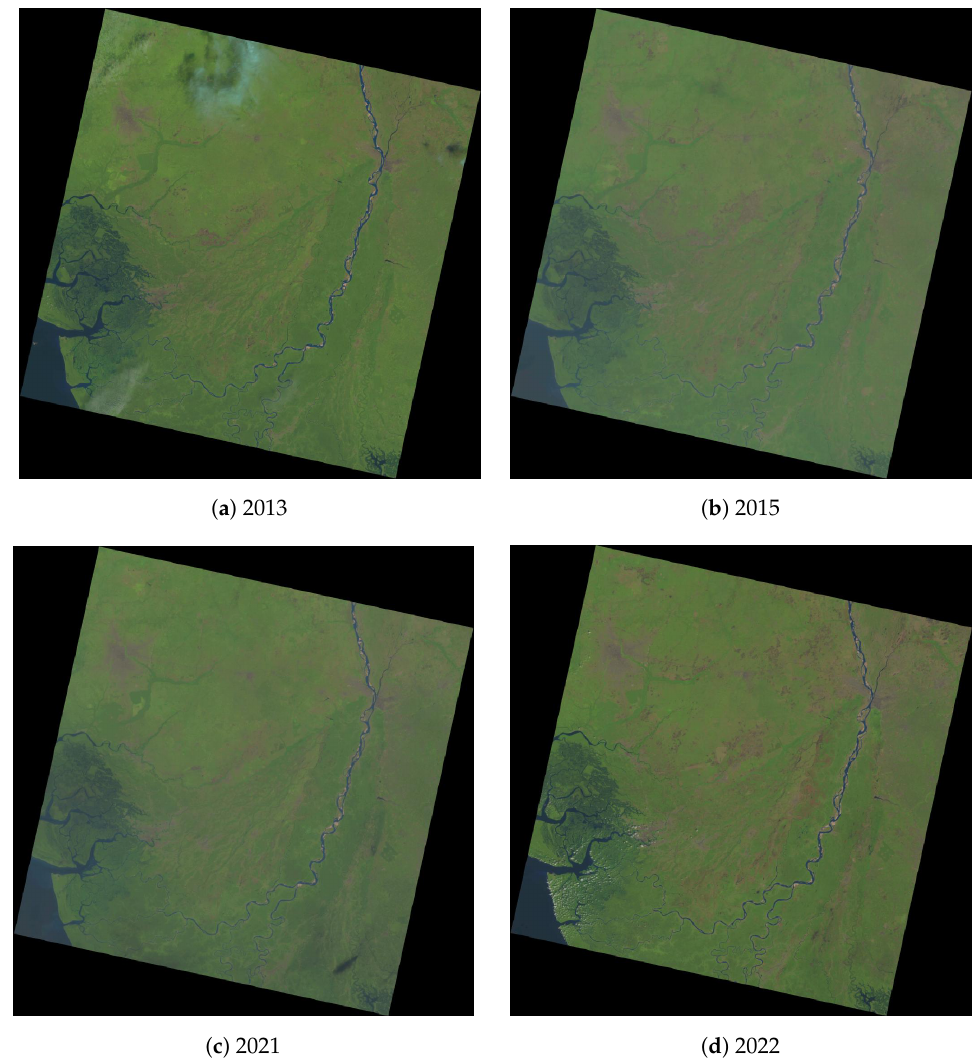
Figure 2. Landsat 8-9 OLI/TIRS images of the Niger River Delta in RGB colors for four years: ( a ) 20 December 2013, ( b ) 26 December 2015, ( c ) 18 December 2021, ( d ) 29 December